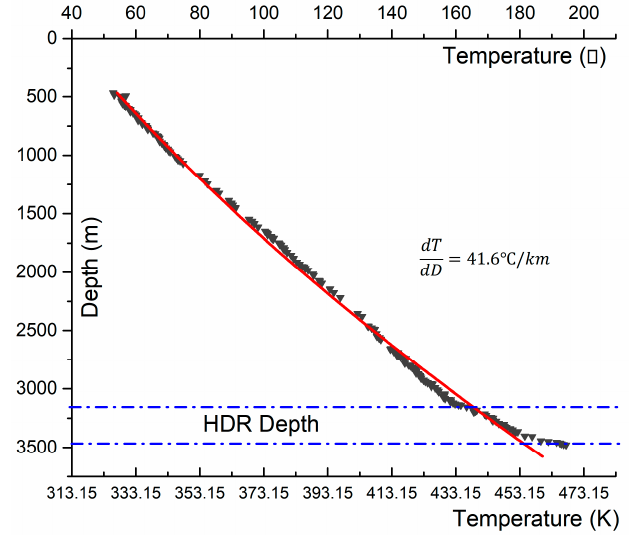
Figure 4. Borehole temperature distribution from well logging data and average geothermal gradient.